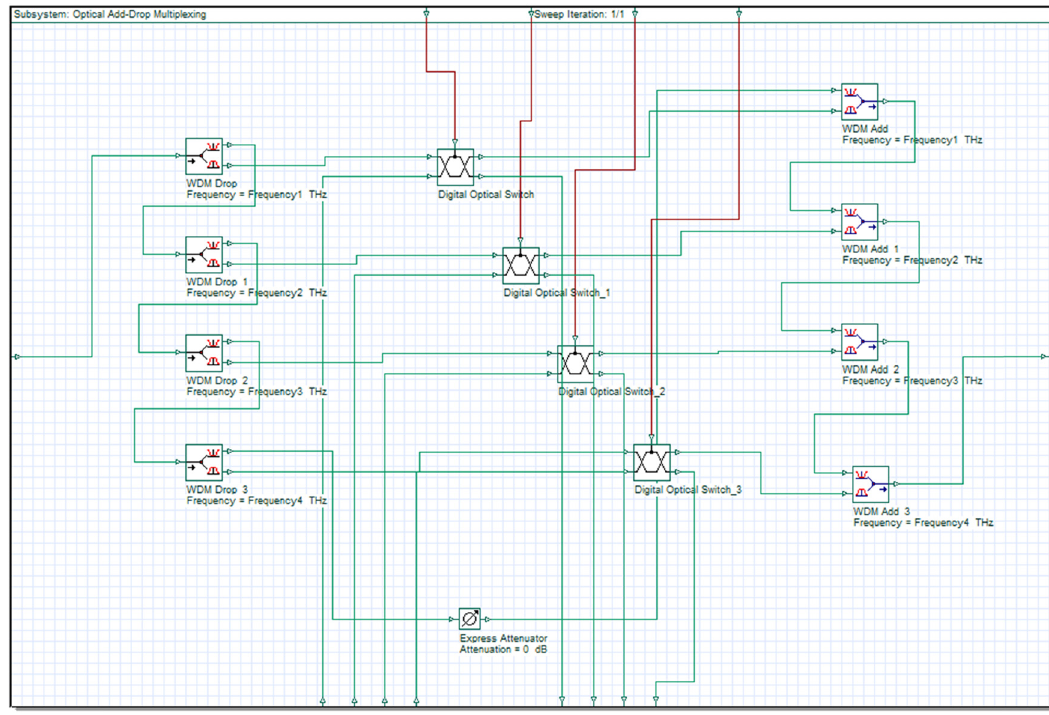
Figure 3: The subsystem of optical add – drop multiplexing